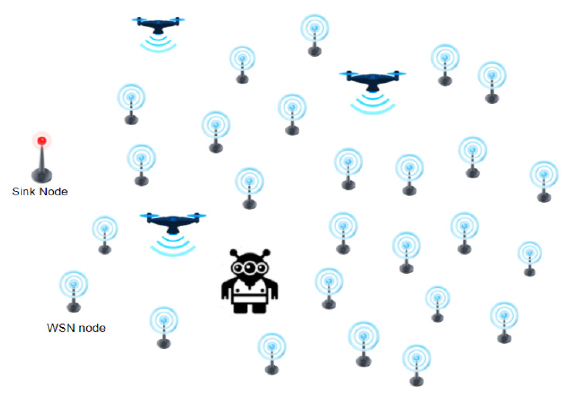
Figure 2. Modernized Wireless Sensor Network (WSN).